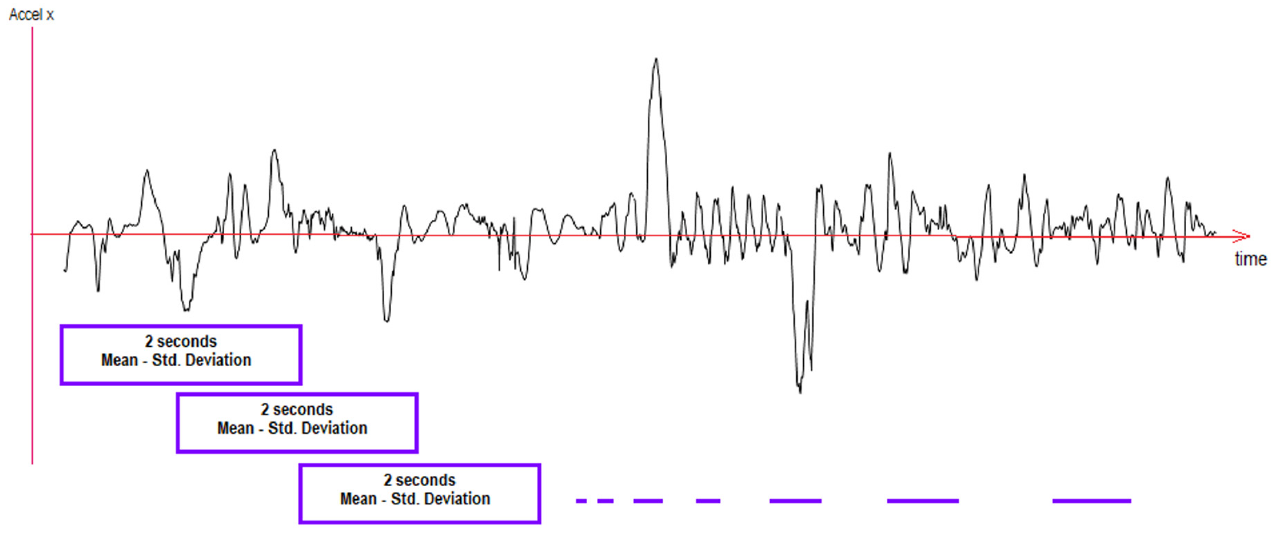
Figure 8. Feature extraction along accelerometer data on x Figure 8 . Feature extraction along accelerometer data on x axis.